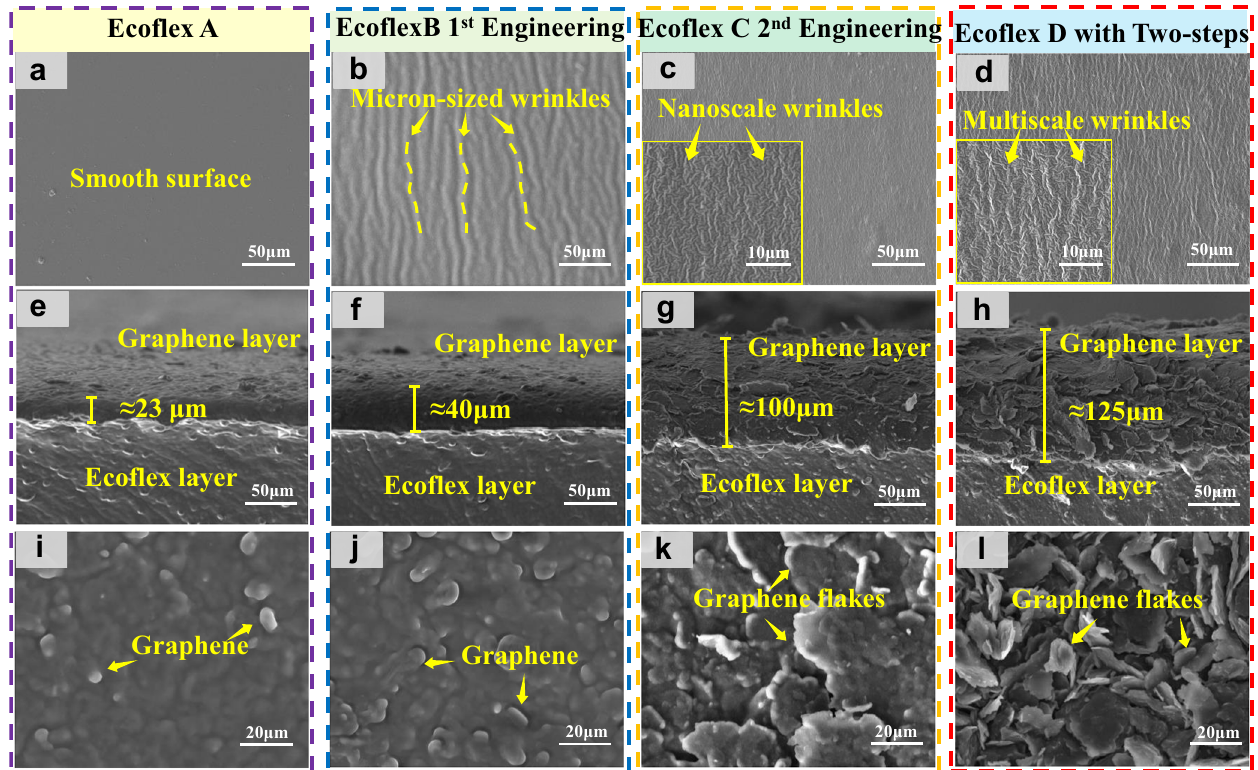
Fig. 2 The SEM characterization of different types of graphene/Eco fl ex. SEM images of surfaces of a Eco fl exA, b Eco fl exB, c Eco fl exC, d Eco fl exD; SEM images of cross-sectional morphologies of e graphene/Eco fl exA, f graphene/Eco fl exB, g graphene/Eco fl exC, h graphene/ Eco fl exD; SEM images of surfaces for i graphene/Eco fl exA, j graphene/Eco fl exB, k graphene/Eco fl exC, l graphene/Eco fl